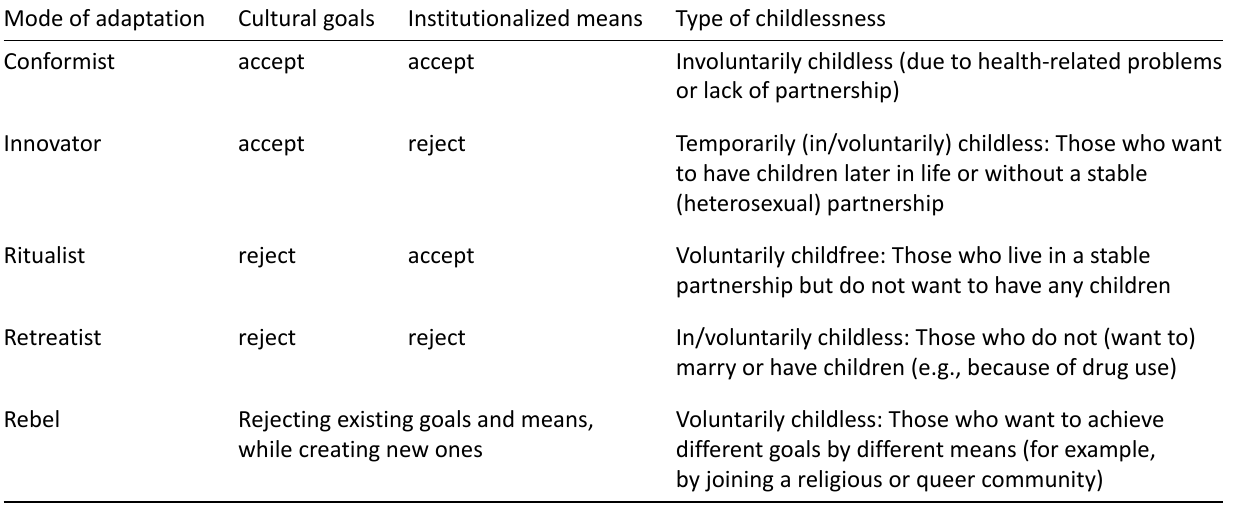
Table 2. Categories of childlessness based on Merton’s anomie theory. Mode of